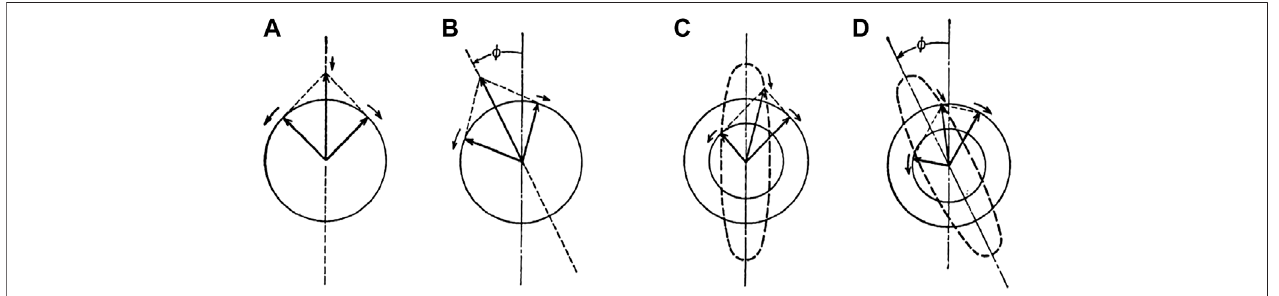
FIGURE 2 | Origin of Faraday rotation and Faraday ellipticity (Magnetic fi eld is applied perpendicular to the surface of the paper (A) Linearly polarized (LP) light can be decomposed to right circularly polarized (RCP) and left circularly polarized (LCP) lights (B) When the phase of the RCP wave advances faster than that of the LCP wave, composed polarization of the light transmitted three the medium is LP rotated from the incident LP. (C) When the amplitude of the RCP wave is larger than that of theLCPwave,composedpolarizationshowsatrajectoryofanellipse. (D) WhentheamplitudeandphaseofRCPandLCParedifferent,thetrajectorybecomes an ellipse with the principal axis